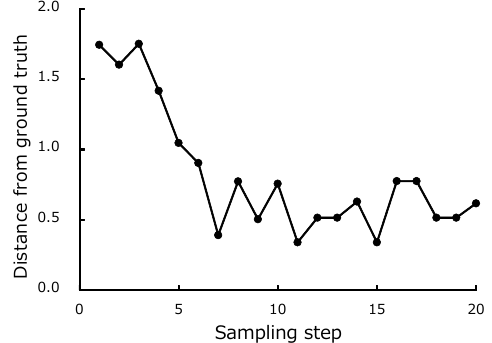
Figure 10: Change of distance between a ground truth and the esti- mation corresponding to Fig.